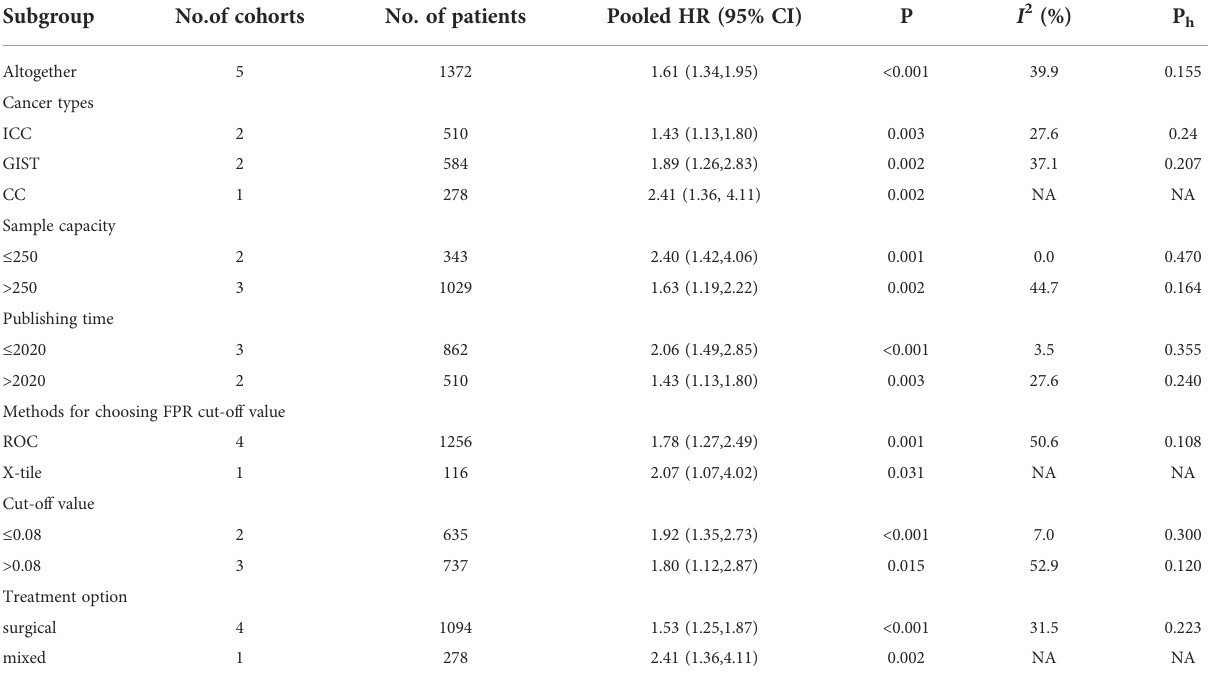
TABLE 4 Subgroup meta-analysis of FAR and